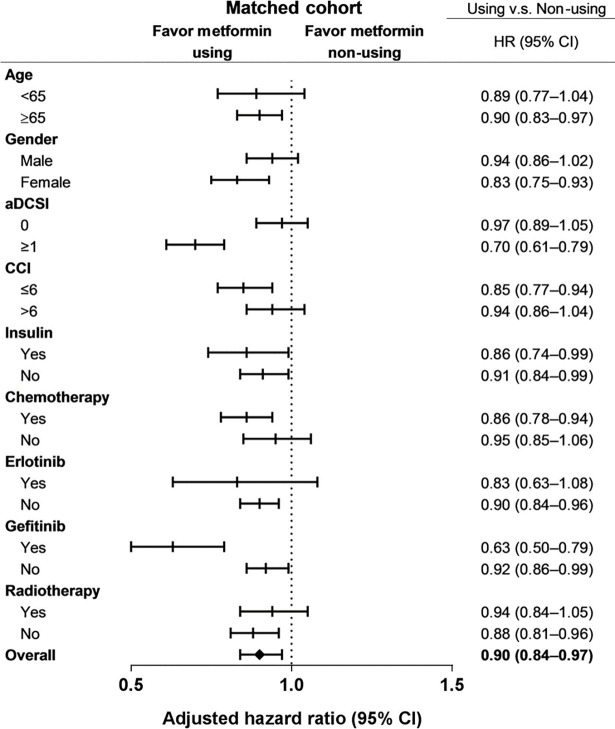
Subgroup analysis of adjusted hazard ratios (HRs) of risk factors for metformin-related mortality in the matched cohorts.